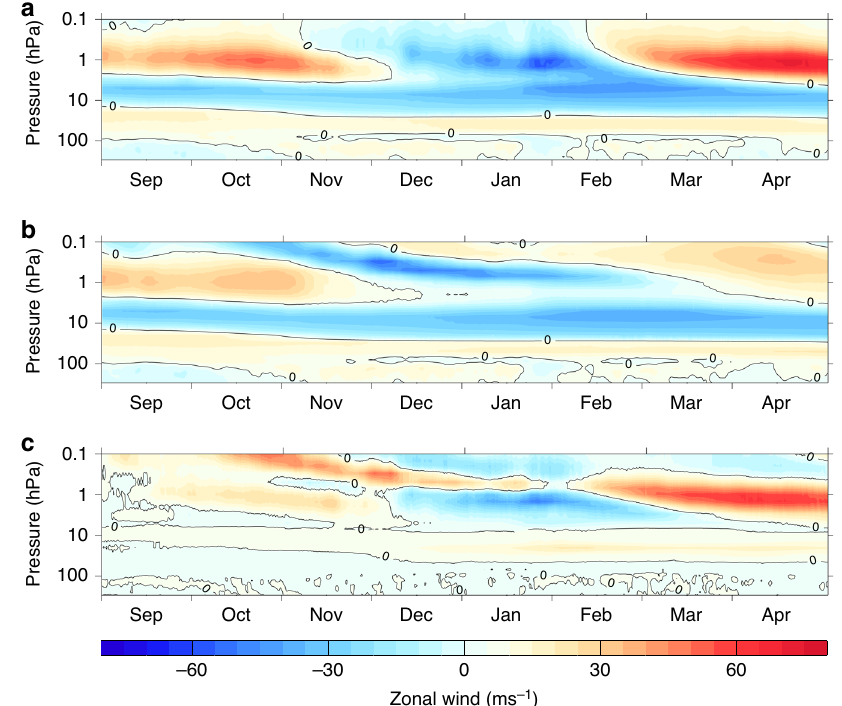
Fig. 4 Evolution of the semi-annual oscillation (SAO). Comparison of the time evolution of 2008/9 zonally averaged zonal winds (ms − 1 ) at equatorial latitudes. a shows the AllTrop-UpStrat-Eq experiment that successfully reproduced the timing of the observed January 2009 SSW event. b shows the AllTrop experiment that achieved an SSW event but with incorrect timing. c shows the difference between the two experiments (AllTrop-UpStrat-Eq minus AllTrop). Both experiments were initialised in September with the correct phase of the quasi-biennial oscillation in the lower stratosphere (i.e., the westerly winds at 20 – 100 hPa in 4a and 4b), and this is successfully maintained in both experiments by the gravity wave scheme. The only difference in the experimental set-up is that the AllTrop-UpStrat-Eq experiment included an additional relaxation of the zonal winds towards the European Centre Reanalysis (ERA-Interim) data in the upper equatorial stratosphere (between 0 and 10 o N above 5 hPa) to ensure the correct evolution of the SAO. The equatorial winds above 5 hPa in the AllTrop-UpStrat-Eq experiment are therefore identical to the ERA-Interim data whereas they evolve freely in the AllTrop experiment. The difference in the two evolutions indicates an underlying easterly bias in the early winter of the freely evolving